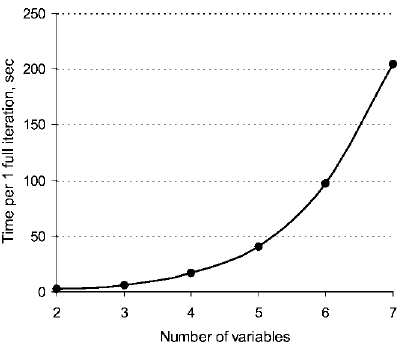
Fig. 2. Time required by MMM to complete one full iteration, in de- pendence on the number of correlated variables included. Calcula- tions were performed by a PC equipped with AMD Athlon processor 700 MHz and 128 MB memory on a data set containing 15378 cells nested within 78